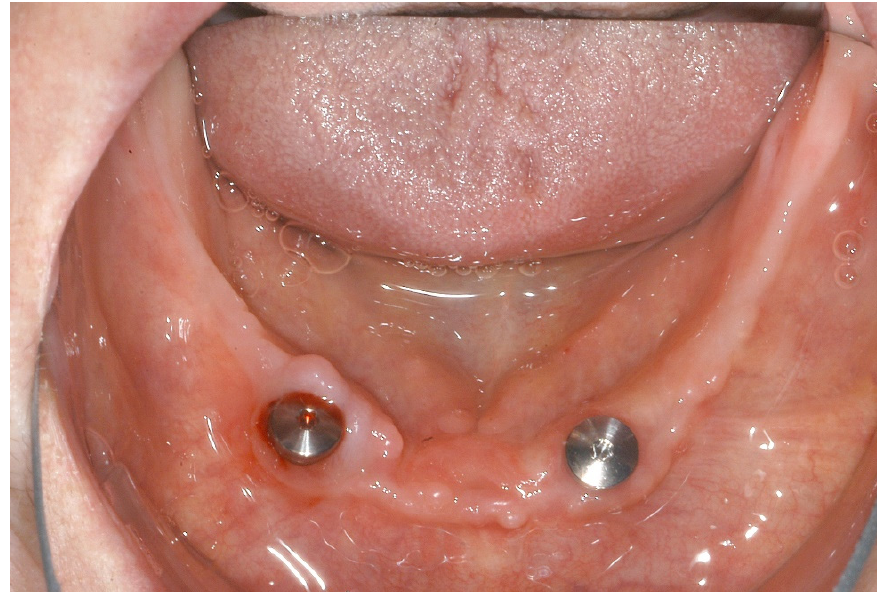
Figure 5. Healing caps after uncovery.